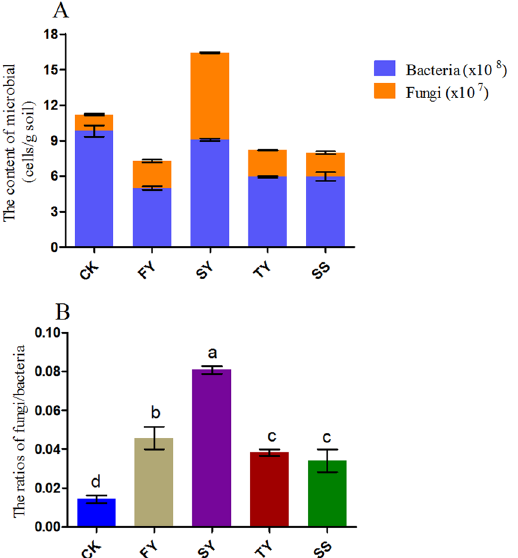
Figure 3. The total bacterial and fungal populations in R. pseudostellariae rhizosphere soil under different years of monoculture. A represents the contents of bacteria and fungi; B represents the ratios of fungi to bacteria. CK represents the control with no R. pseudostellariae cultivation. FY, SY, and TY represent the newly planted, two-year and three-year monocultured R. pseudostellariae , respectively, grown in fields. SS represents the soil around the pathogenic site of R. pseudostellariae . These soils were sampled from the rhizosphere soil of the fields at the same time during the later tuberous root stage of R. pseudostellariae . Columns with different letters are statistically different (LSD test, p <